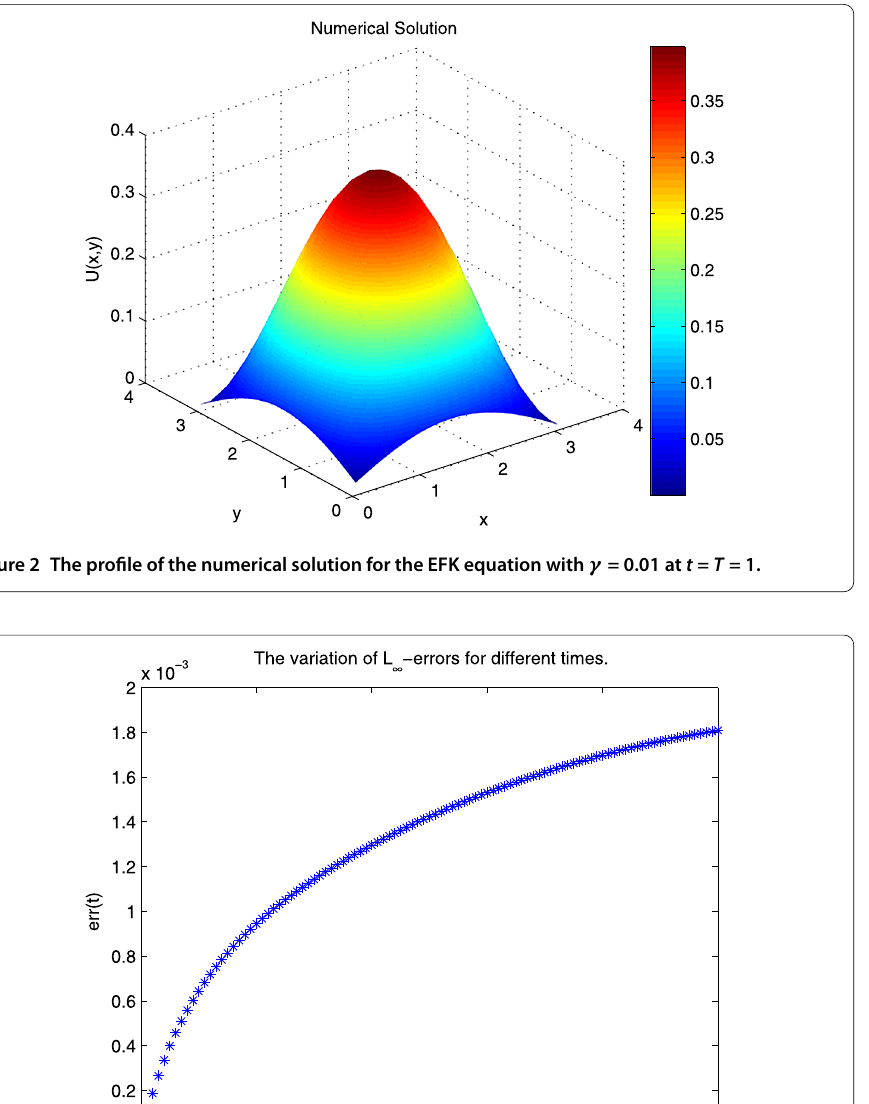
with the initial